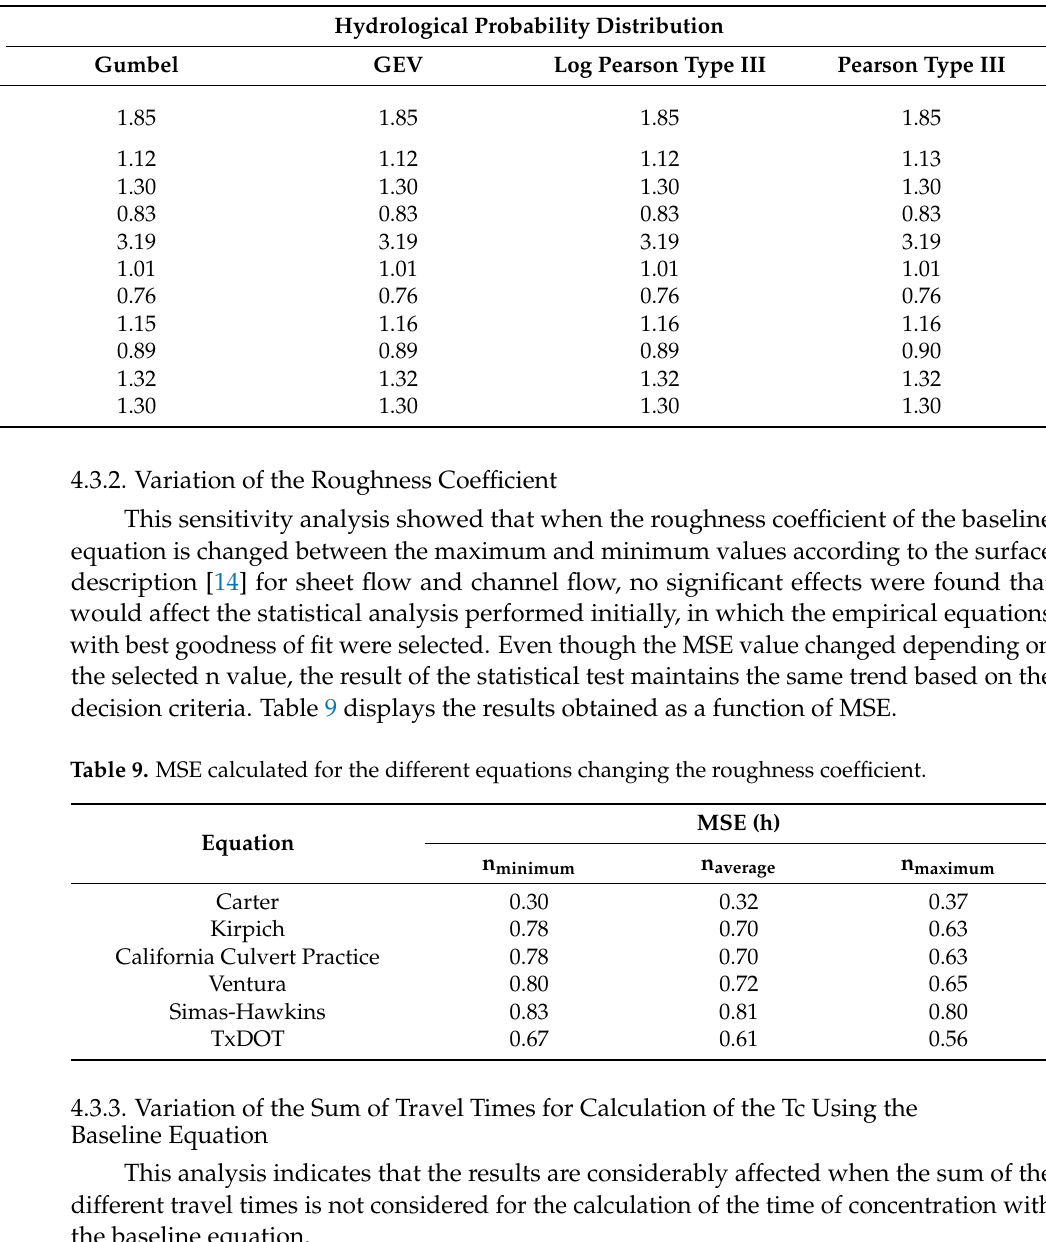
Table 8. Tc calculated with the baseline equation changing Pmax-24 h, Tr 2 , P 2 in F l .